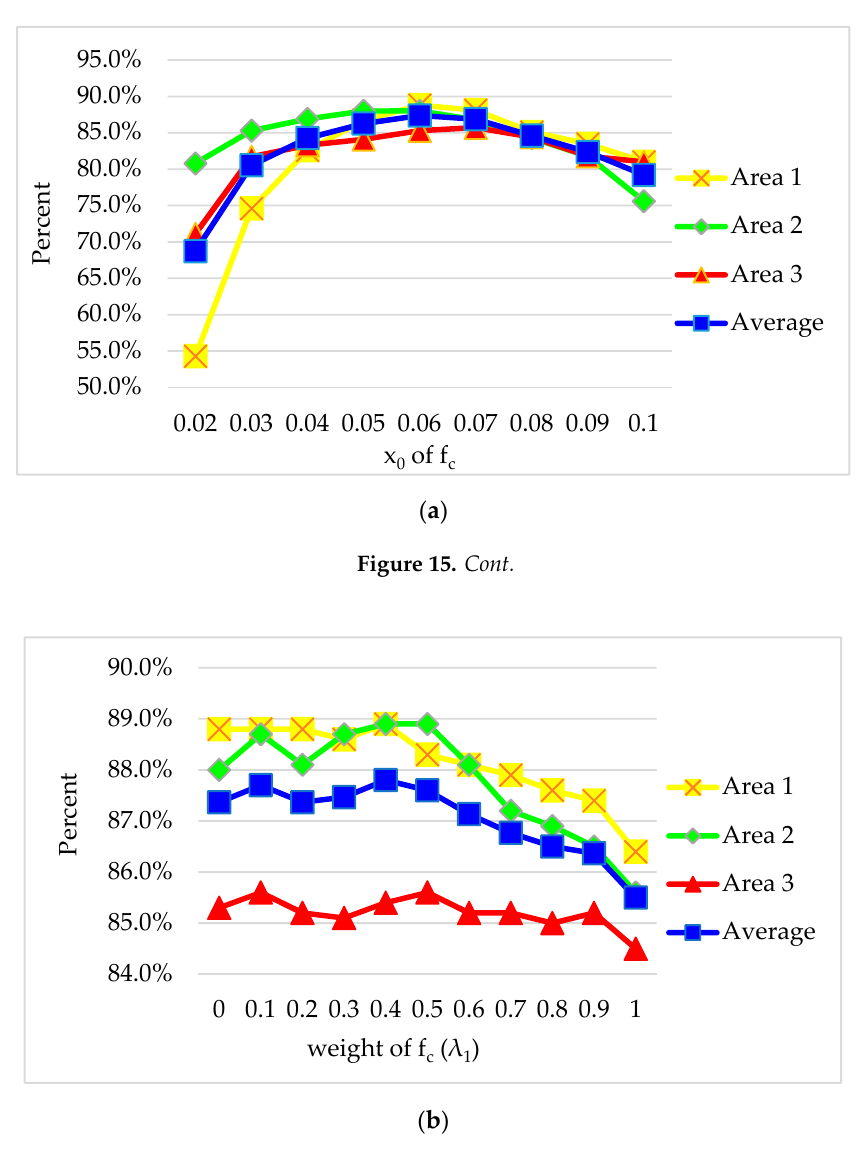
Figure 15. Results of di ff erent x 0 for f c and di ff erent weights for features. ( a ) Results of di ff erent x 0 for f c ; ( b ) Results of di ff erent weights for each feature.